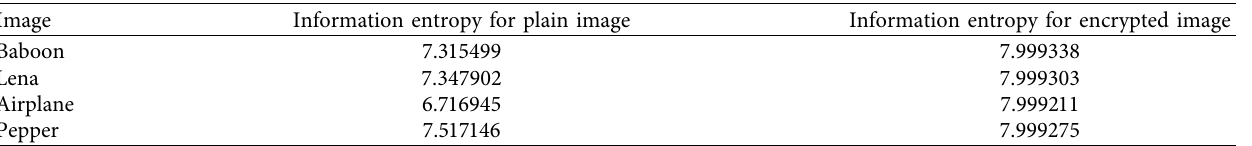
Figure 7: Key sensitivity analysis results: (a) a plain image for airplane; (b) a cipher image encrypted using the first key code; (c) a cipher image encrypted using the second key code; and (d) the difference between (b) and (c). Table 3: Information entropies of the plain and encrypted figures.